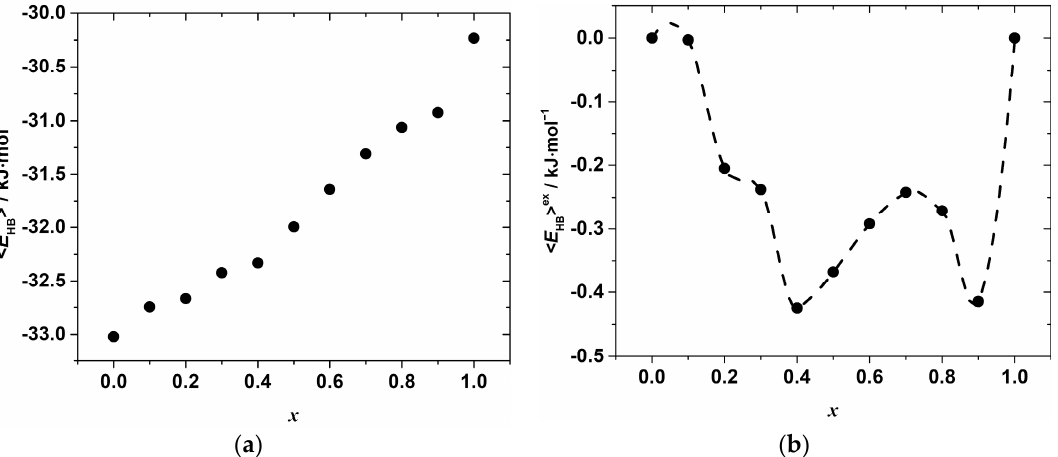
Figure 8. Compositional dependences of the ( a ) mean N-H···X hydrogen bond energy per mole of CH 3 NH 3 Pb(Cl 1 − x Br x ) 3 solid solution ( b ) excess N-H···X hydrogen bond energy per mole of the solid solution.